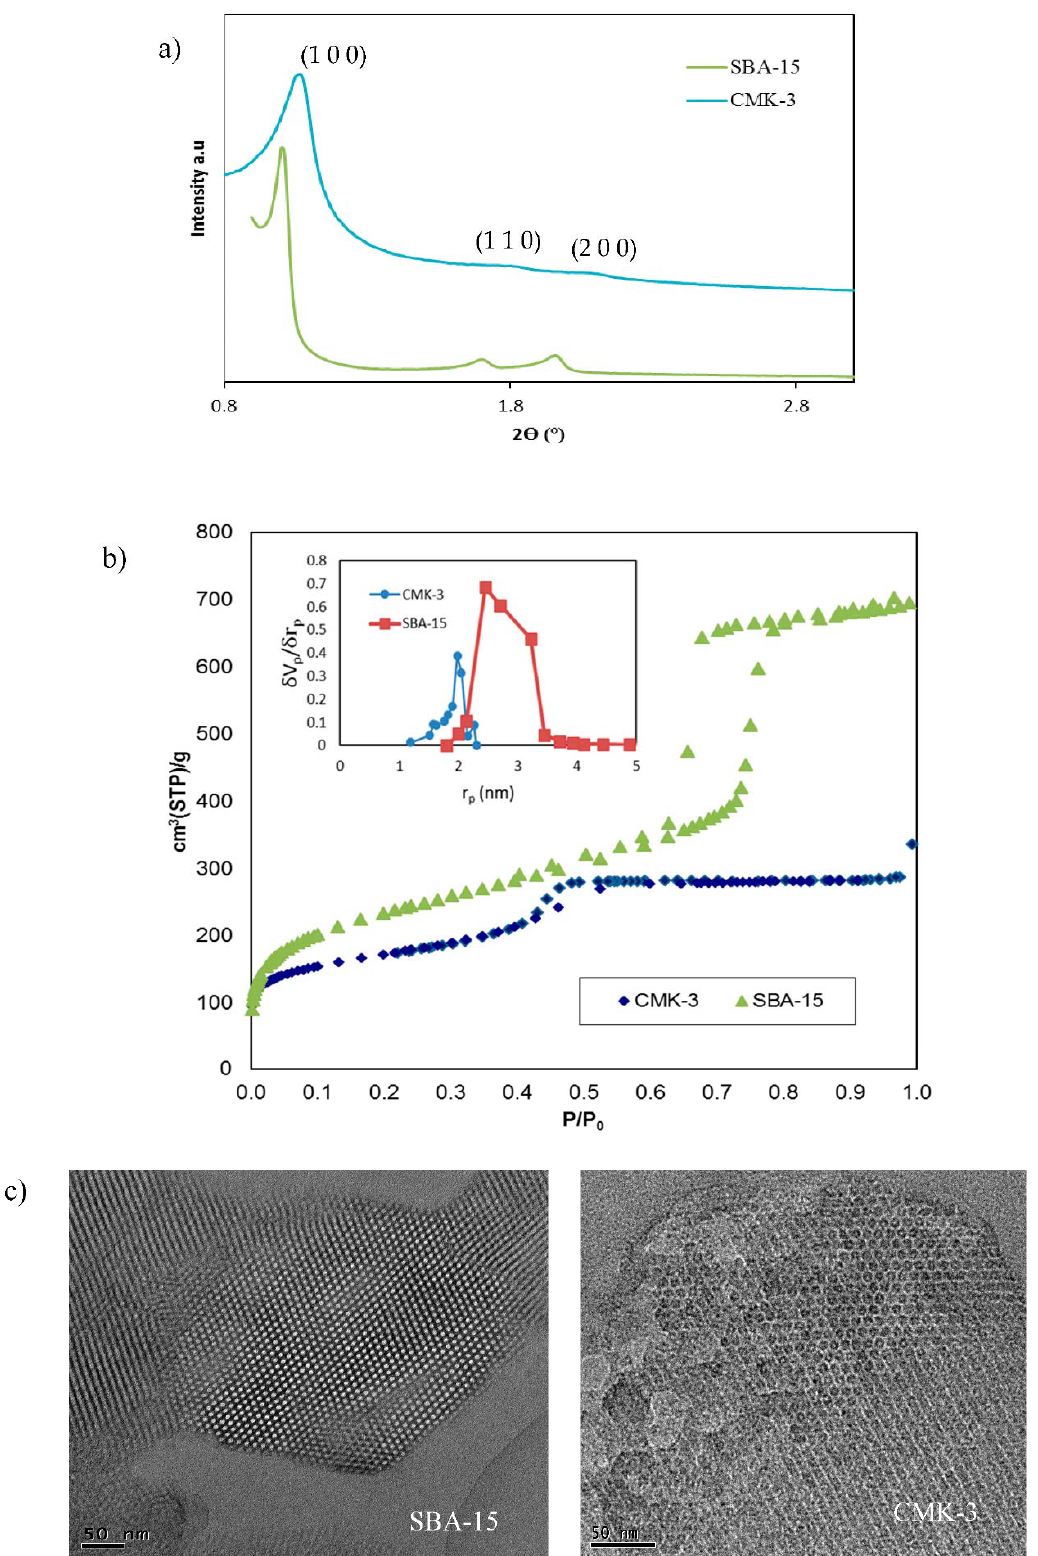
Figure 1. XRD diffractogram of SBA-15 and CMK-3 ( a ), nitrogen sorption isotherms ( b ) and TEM images ( c ).